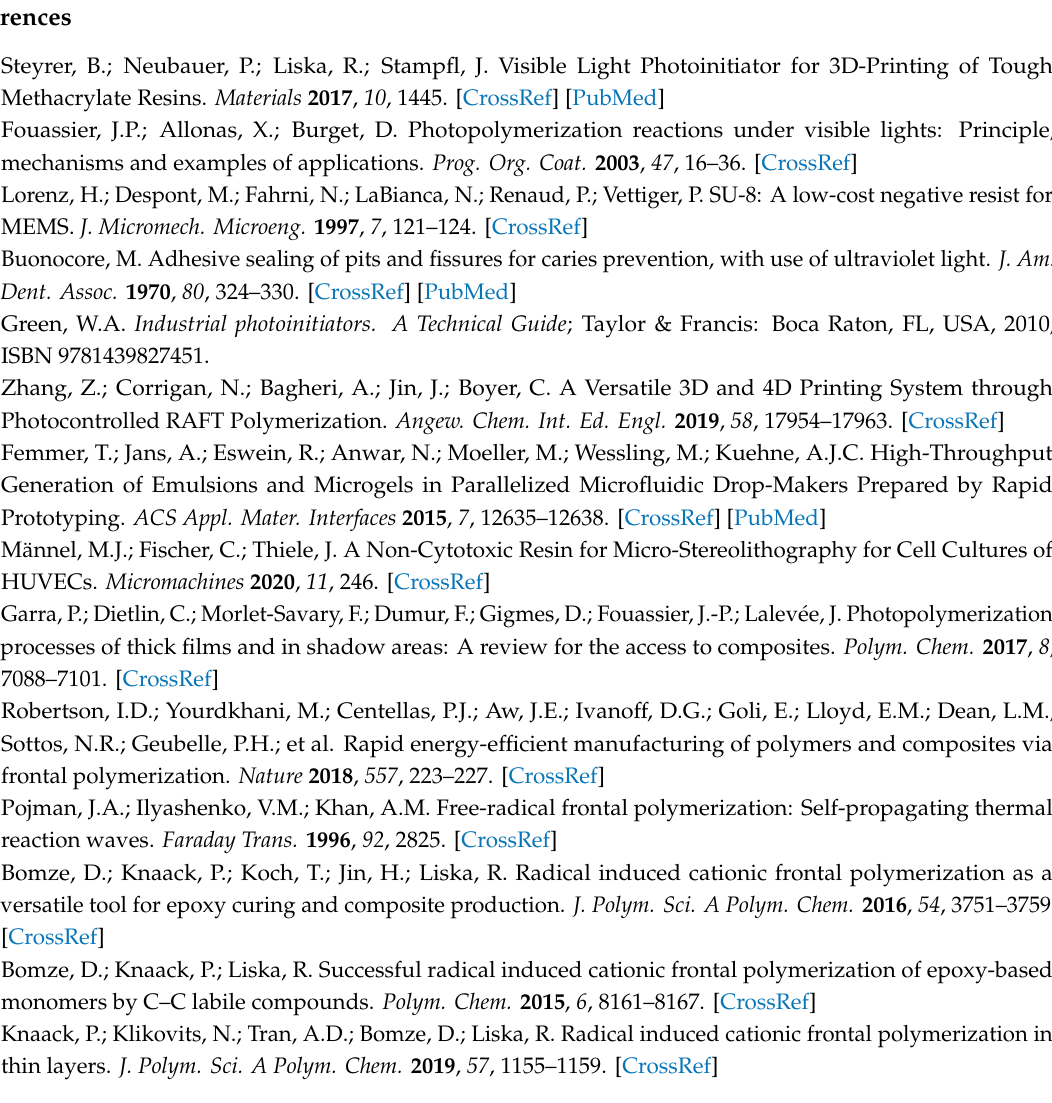
Figure S1a–d: Swelling ratios of specimens derived from PBS A–F in ethanol and